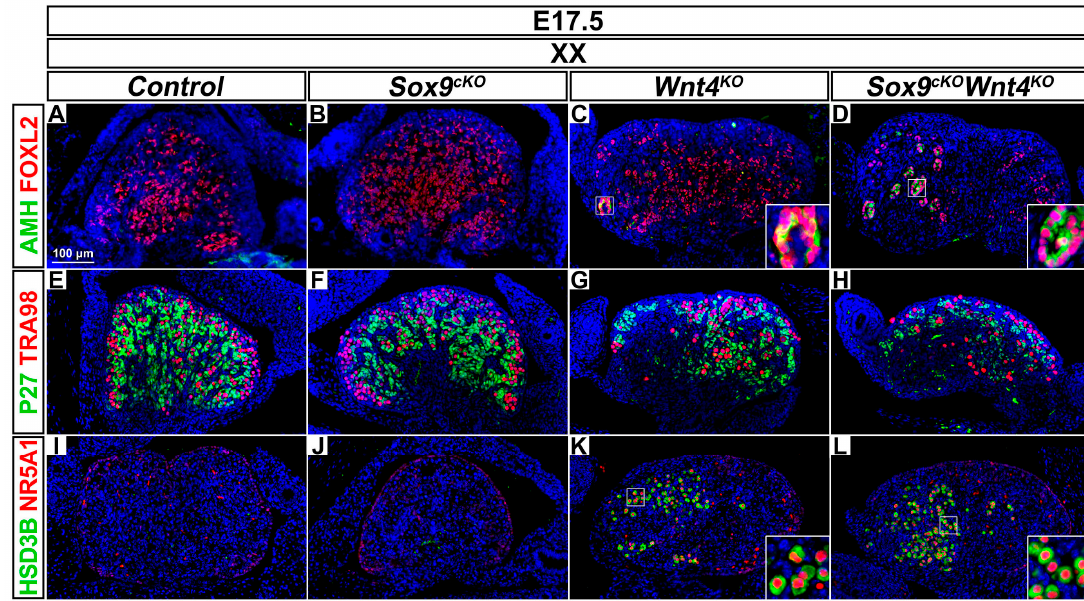
Figure 2. Abnormal ovarian development in XX Wnt4 mutants is independent of SOX9 function. ( A – D ) Immunodetection of the differentiation marker AMH (green) and the pre-granulosa cell marker FOXL2 (red) in E17.5 XX gonads of Control ( A ), Sox9 cKO ( B ), Wnt4 KO ( C ) and Sox9 cKO Wnt4 KO ( D ) genotypes. ( E – H ) Immunodetection of the quiescent cell marker P27 (green) and the germ cell marker TRA98 (red) in E17.5 XX gonads of Control ( E ), Sox9 cKO ( F ), Wnt4 KO ( G ) and Sox9 cKO Wnt4 KO ( H ) genotypes. ( I – L ) Immunodetection of the steroidogenic enzyme HSD3 β (green) and the steroidogenic transcription factor NR5A1 (red) in E17.5 XX gonads of Control ( I ), Sox9 cKO ( J ), Wnt4 KO ( K ), and Sox9 cKO Wnt4 KO ( L ) genotypes. Nuclei labeled with DAPI are shown in blue. Magnification is the same in all panels. Scale bar = 100 µm.